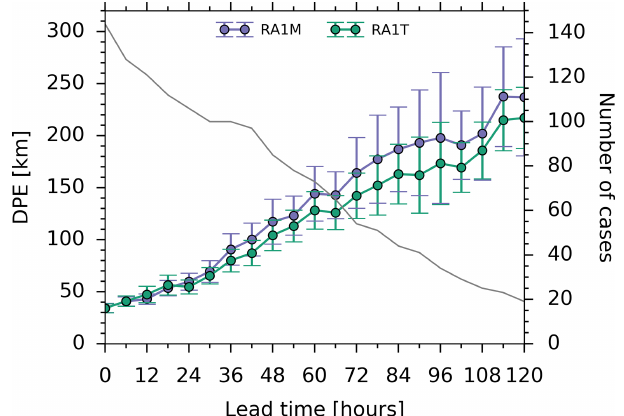
Figure 21. Error in forecast storm position relative to observations (direct positional error, DPE) as a function of lead time for the RAL1-T and RAL1-M models. Error bars are 95% confidence in- tervals on the mean. The solid grey lines indicate the number of storm cases (see the right-hand axis of the plot).